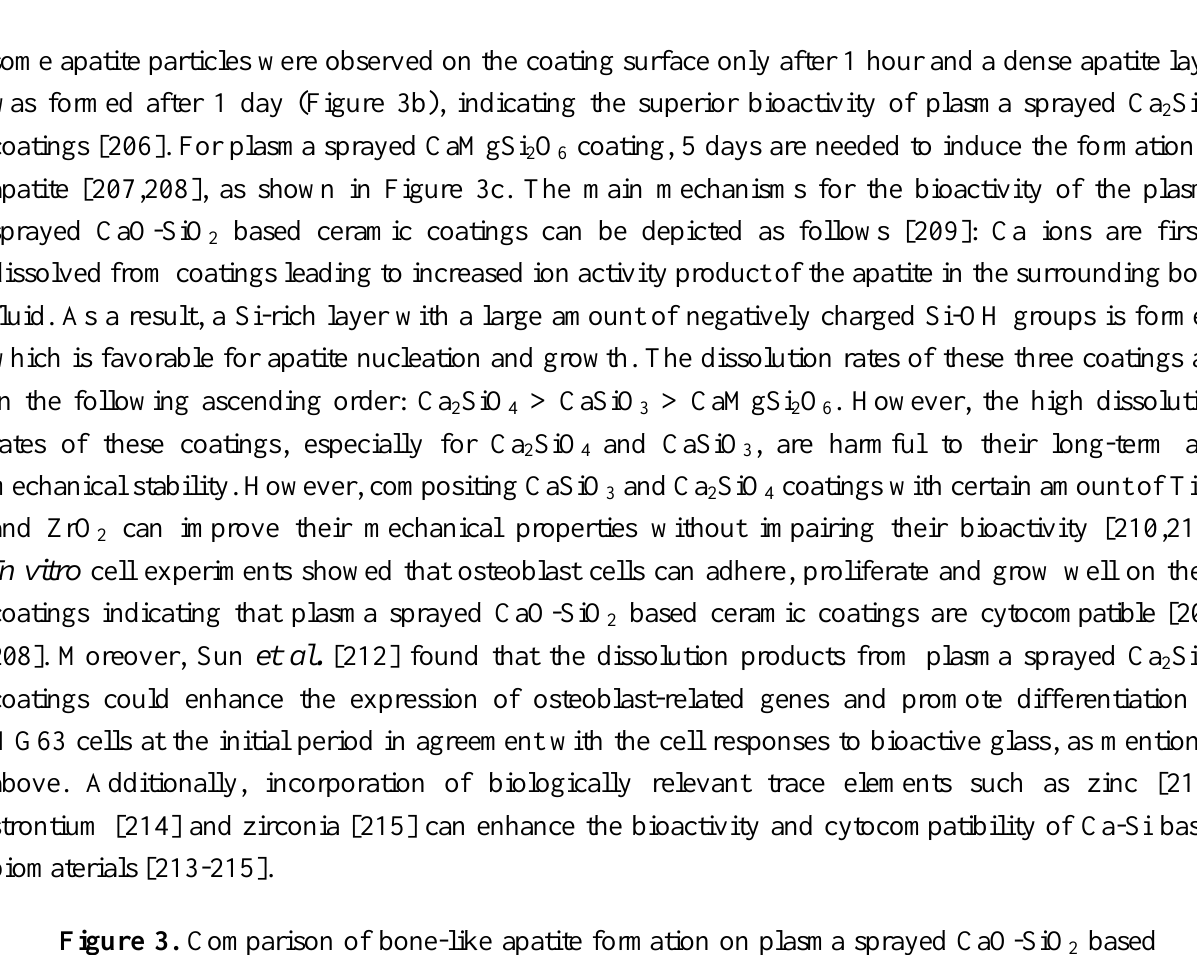
based 2 coating immersed in SBF 3